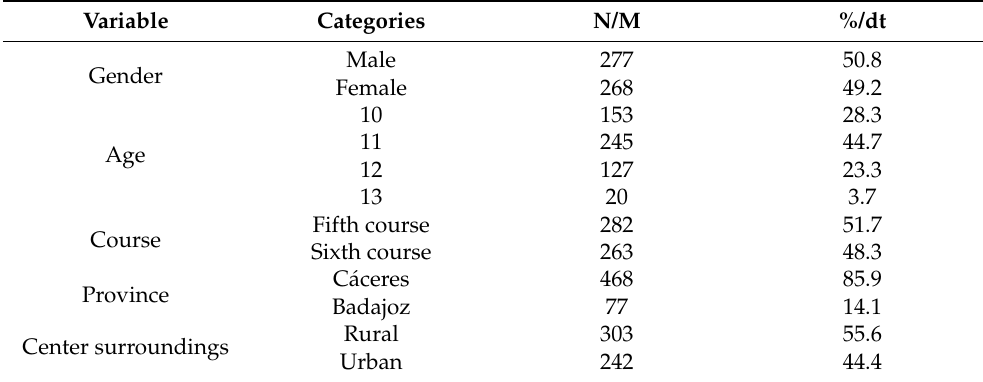
Table 1. The sample’s frequency distribution (N =